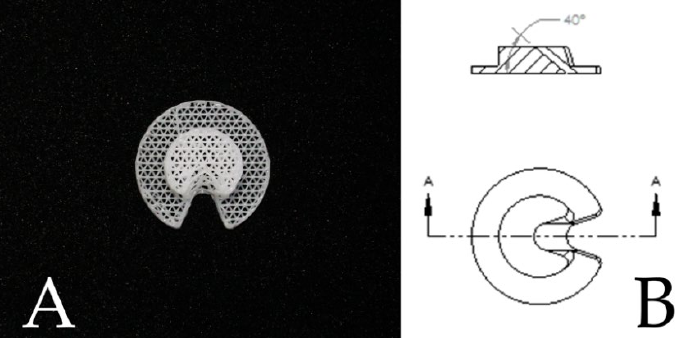
Figure 1. ( A ) A photograph of Design 2, which allows for placement of a subdural drain. ( B ) A Figure 1. (A) A photograph of Design 2, which allows for placement of a subdural drain. (B) A drawing of Design 2 demonstrating the chamfered hole design at 40 ◦ drawing of Design 2 demonstrating the chamfered hole design at 40°. Table 1. Latest designs of Osteoplug TM and in-text references.